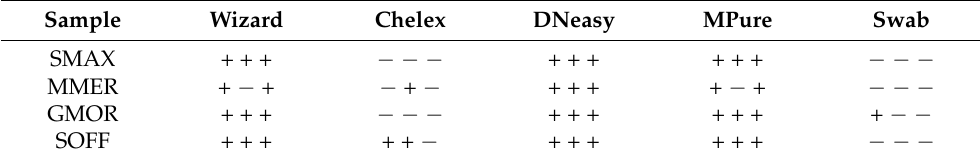
Figure 7. Total amplification success (%) of the tested samples per DNA extraction method. Table 2. Amplification success of PCR products of the tested species per method.